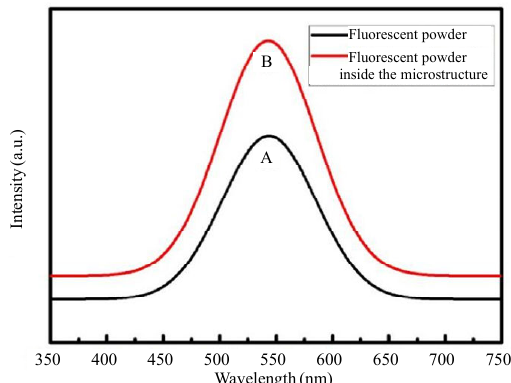
Fig. 6 Fluorescence spectrum of pure fluorescent powder and assembled fluorescent powder.